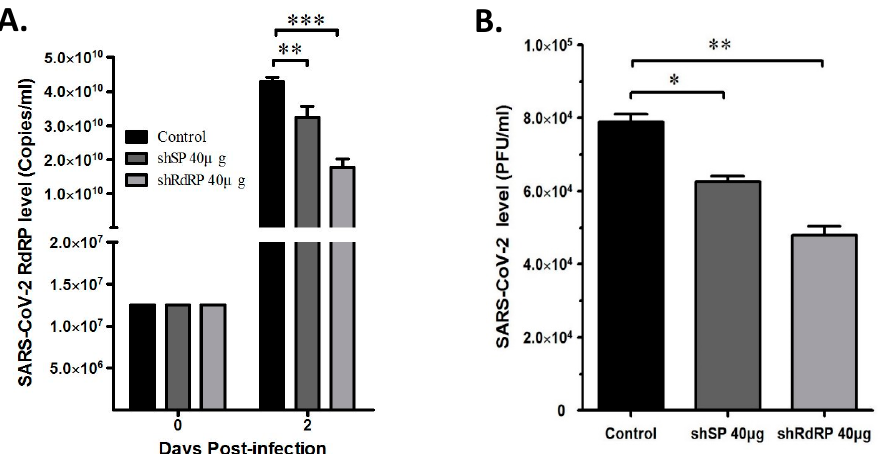
Figure 4. shRNAs targeting a clinically isolated unknown SARS-CoV-2 virus inhibited viral replica- tion. We transfected Vero-E6 cells with pBSSK + , pSIREN-shCoV2019SP, or pSIREN-shCoV2019RdRP and infected the cells with a clinically isolated unknown SARS-CoV-2 strain. We assessed the viral replication and viral titer in the culture supernatant with ( A ) real-time PCR and ( B ) plaque assay 2 days post-infection. We used pBSSK + as a negative control. Three independent experiments were performed. * p < 0.05. ** p < 0.01. *** p < 0.001.